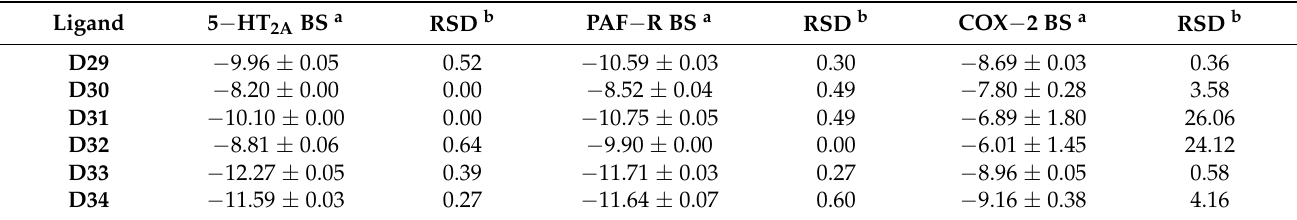
Table 4. Molecular docking results of Group D